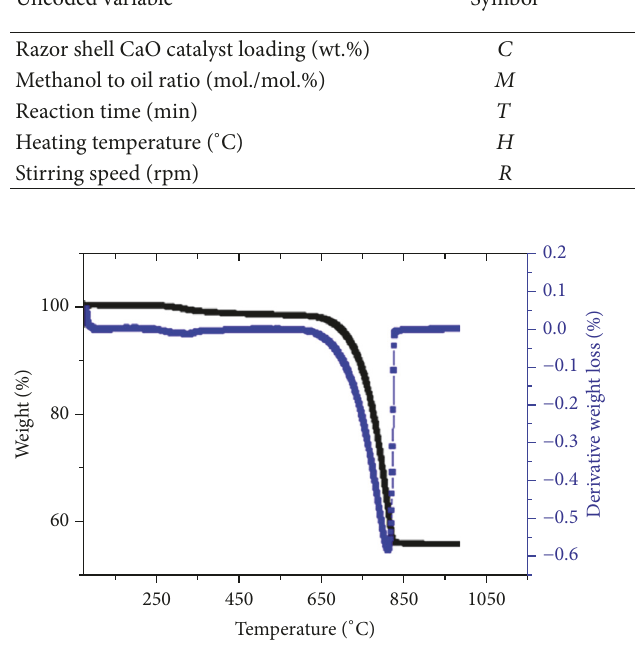
Figure 3: Thermal analysis (TGA/DTA) of Razor shells.